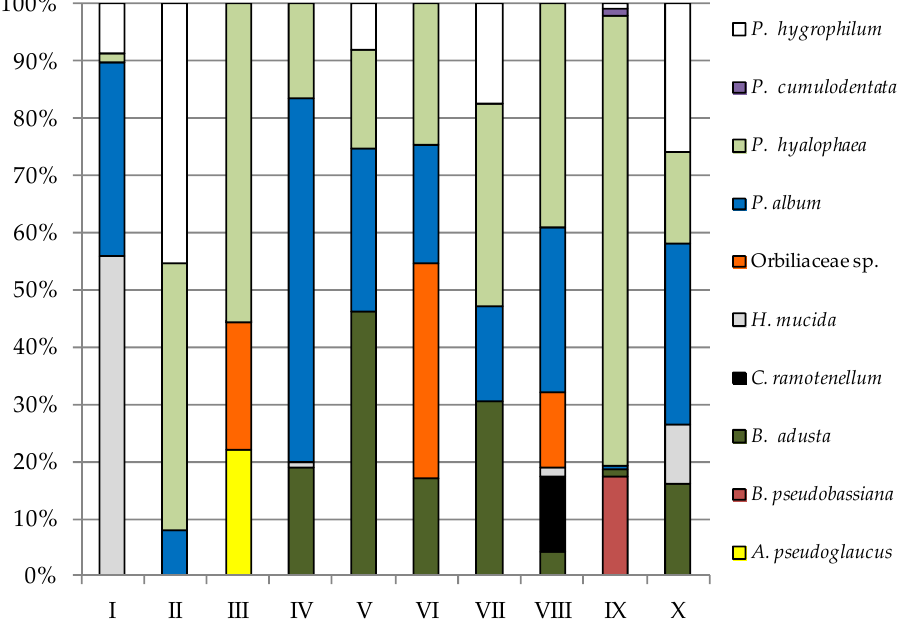
Figure 5. Percentage of each fungus contributing to the total fungi cultured on YPG from the cryoconite holes in the Werenskiold Glacier (Spitsbergen) at 7 °C from study sites I to X. In the case of sampling site I on PDA and YPG, the dominance of H. mucida and Cladosporium allicinum was noted, respectively, to be above 99% of all isolated fungi, taking into account the higher incubation temperature of the biological material (Figures 6 and 7).